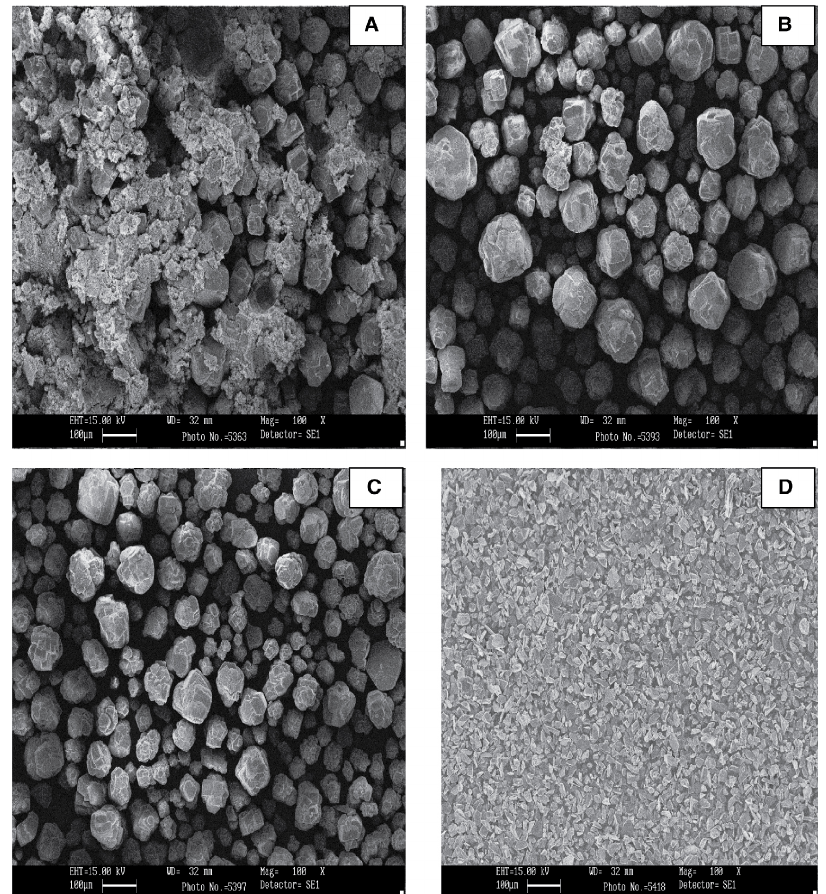
Figure 3: SEM micrographs of milled powders after different milling times (A) 10 h; (B) 20 h; (C) 30 h and (D) 60 h.